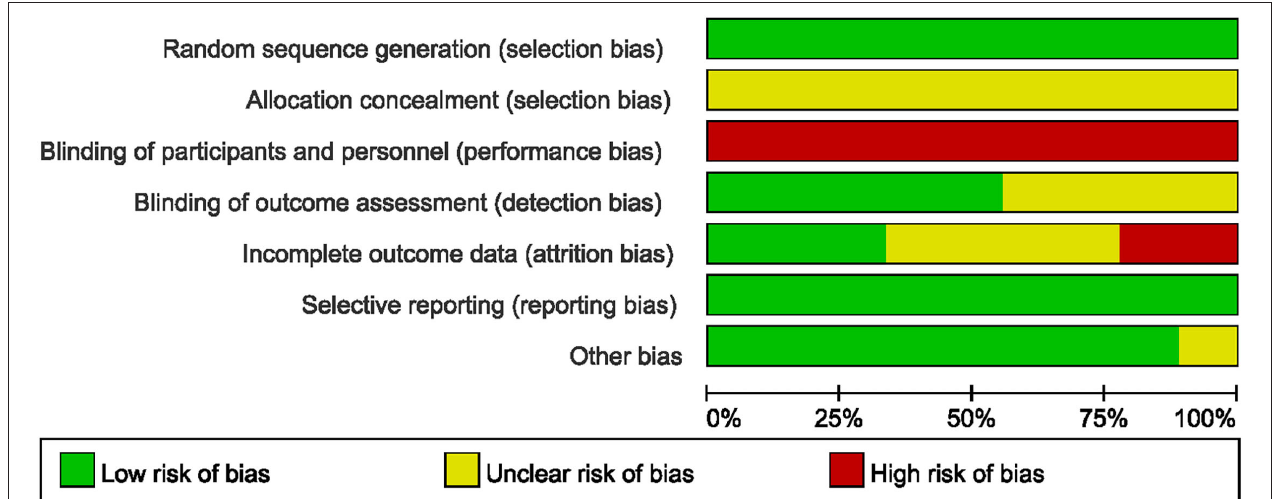
FIGURE 2 | Risk of bias graph across all included